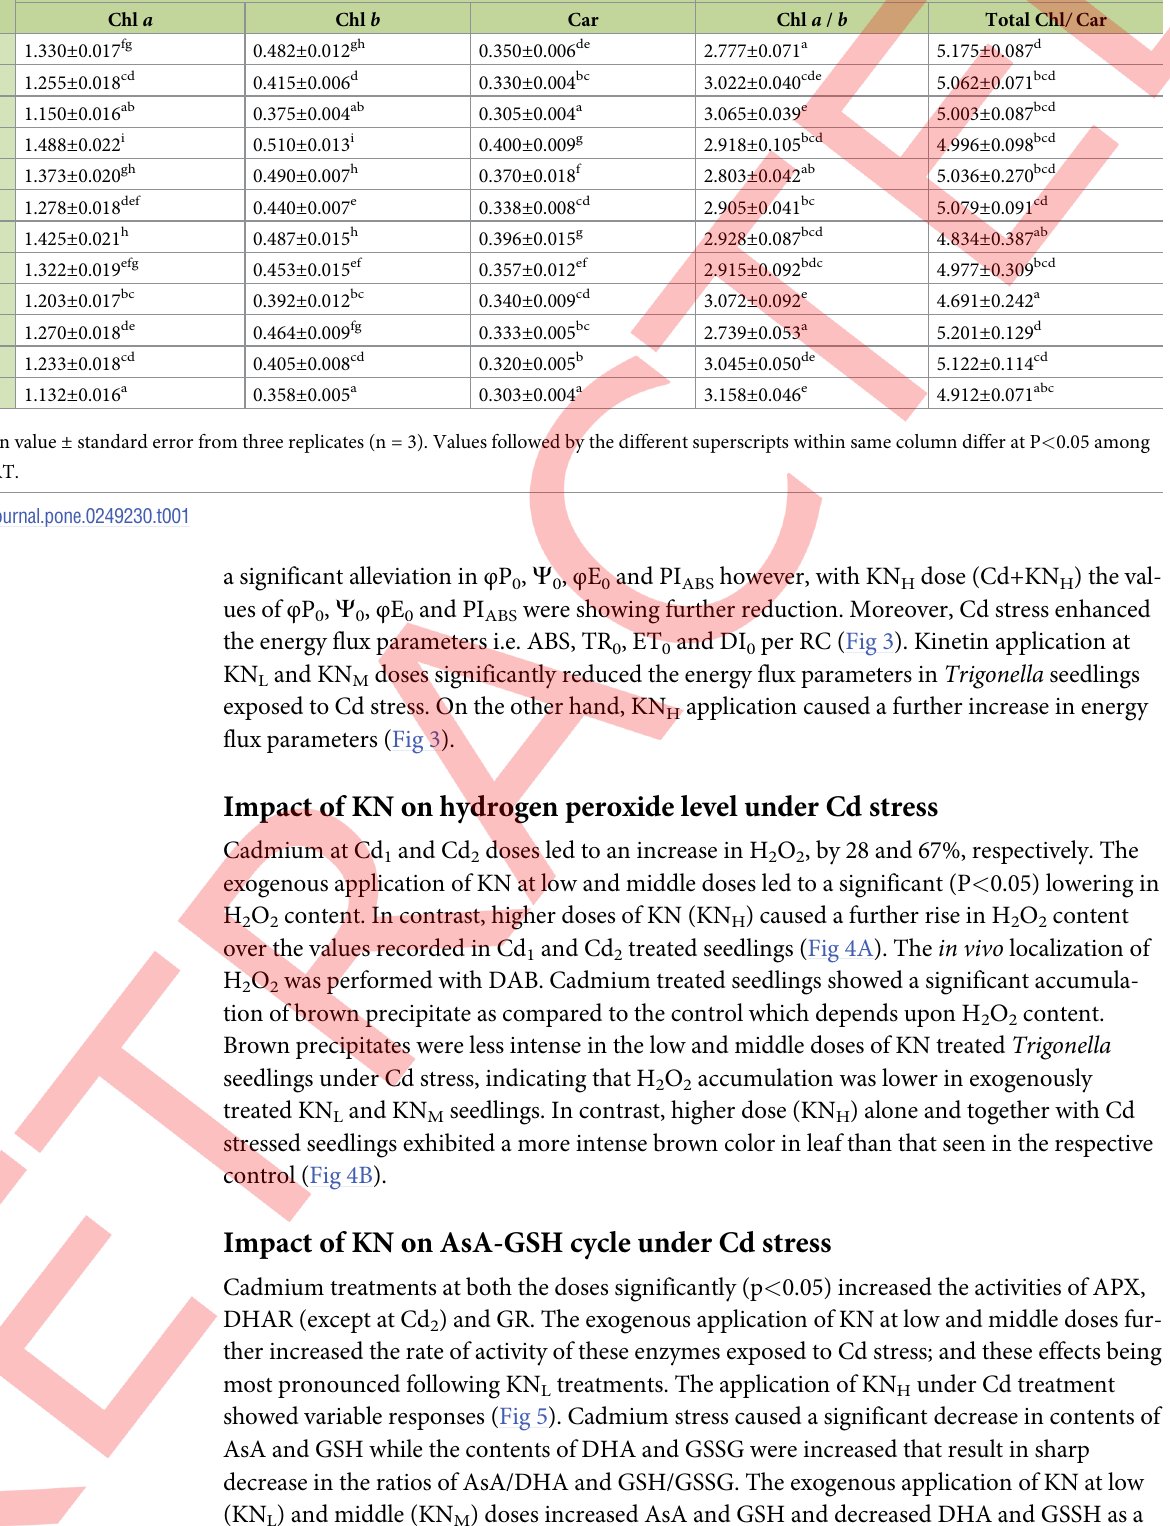
Table 1. Effect of KN on photosynthetic pigment contents of Trigonella seedlings exposed to Cd stress. Treatments